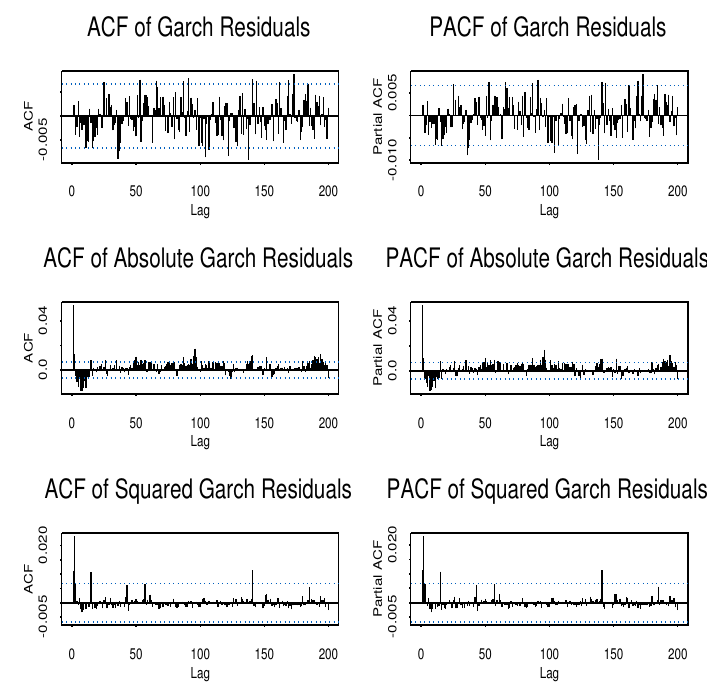
Figure 8. Autocorrelation and partial autocorrelation functions of the residuals, absolute residuals and squared residuals after GARCH